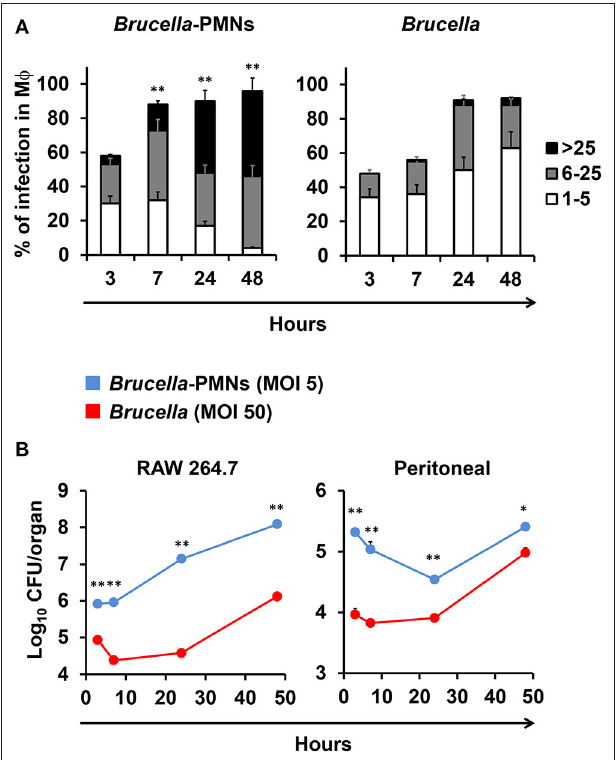
FIGURE 4 | B. abortus- infected PMN promote Brucella infection of M φ s. (A) RAW M φ s were incubated with B. abortus -RFP alone or with B. abortus- infected PMN, then cells were stained (DAPI, for nuclei; phalloidin-FITC for actin filaments), fixed and mounted with MOWIOL, and the number intracellular bacteria (1–5, 6–25, or > 25) per M φ was determined. The proportion of infection and the number of intracellular bacteria was determined by fluorescence microscopy. At least 200 cells were counted per sample. Values of p < 0.05 (*) and p < 0.01 (**) are indicated in relation to M φ s incubated with non-infected PMNs. (B) RAW and peritoneal M φ s were infected with B. abortus- RFP alone (MOI 50) or with B. abortus -RFP infected PMNs (MOI 5) and CFU determined at different time points. These experiments were repeated at least three times.